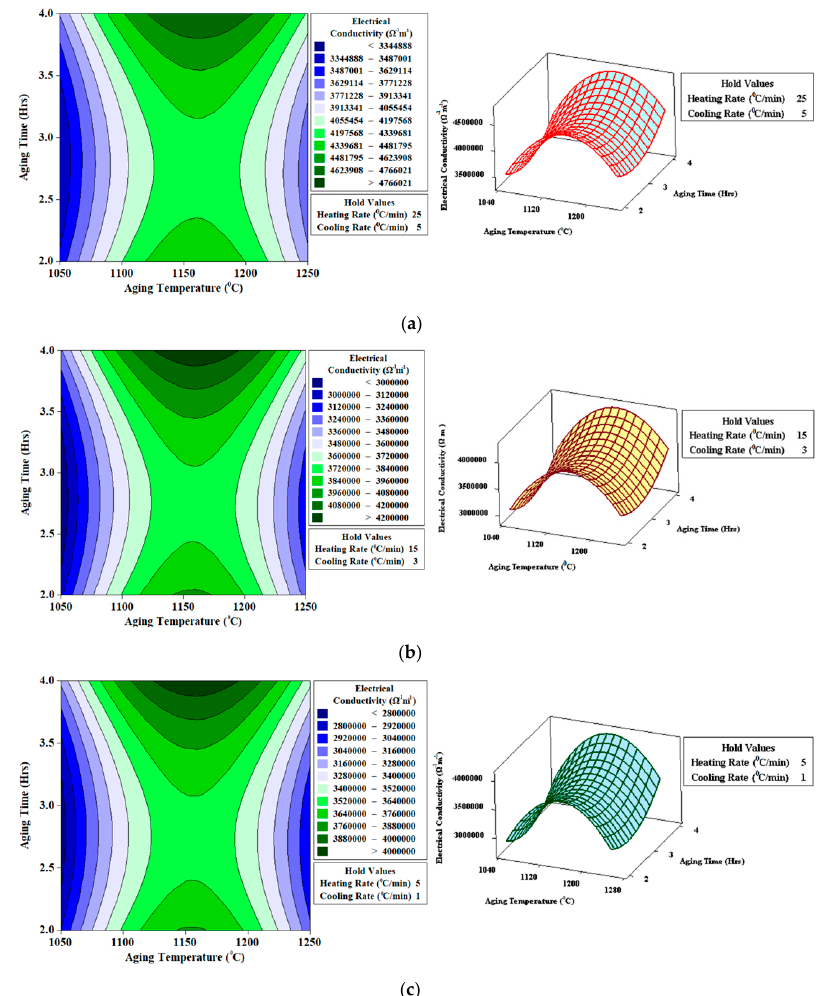
Figure 12. Contour and surface plots for electrical conductivity ( Ω − 1 m − 1 ) ( a ) Heating Rate (25 °C/min); Cooling Rate (5 °C/min) ( b ) Heating Rate (15 °C/min); Cooling Rate (3 °C/min) ( c ) Heat- ◦ C/min); Cooling Rate (5 ◦ C/min) ( b ) Heating Rate (15 ◦ C/min); Cooling Rate (3 ◦ C/min) ing Rate (5 °C/min); Cooling Rate (1 °C/min) (25 ( c ) Heating Rate (5 ◦ C/min); Cooling Rate (1 ◦